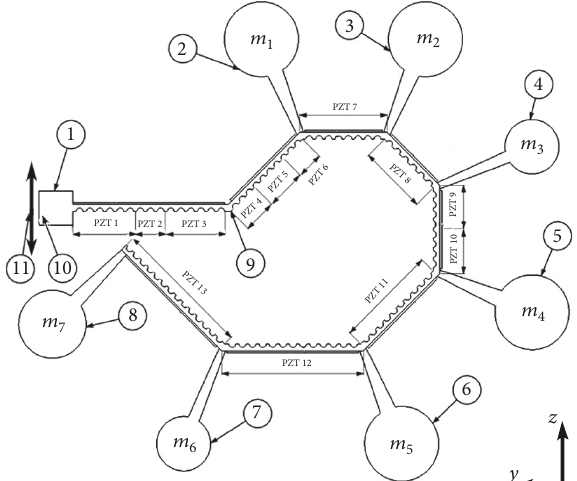
Figure 3: Principle scheme of the piezoelectric polygon-shaped energy harvester: A base of harvester; B ⋅⋅⋅ H seismic masses (C17200 beryllium bronze); PZT 1 ⋅⋅⋅ PZT 13 : piezoceramic layers (PIC255); 0 body of harvester (C17200 beryllium bronze); 1 fixed constrain; 2 direction of the excitation.